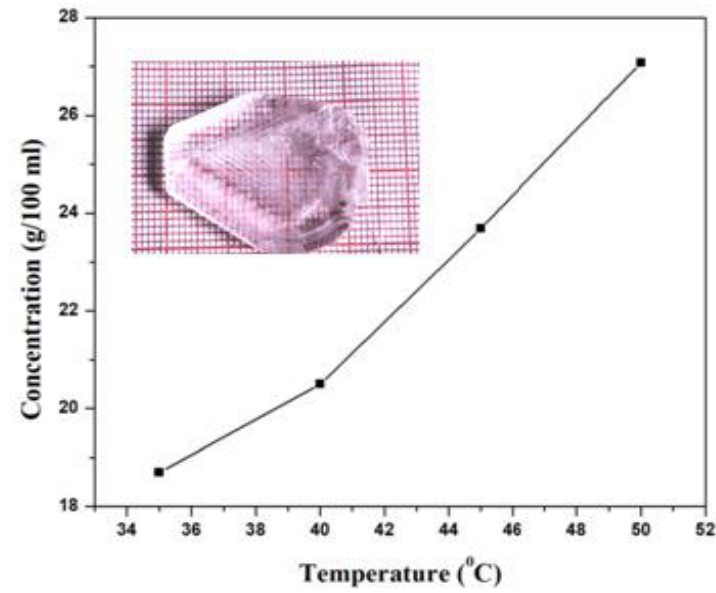
Figure 1. Solubility curve for UGA crystal with grown crystal inside.